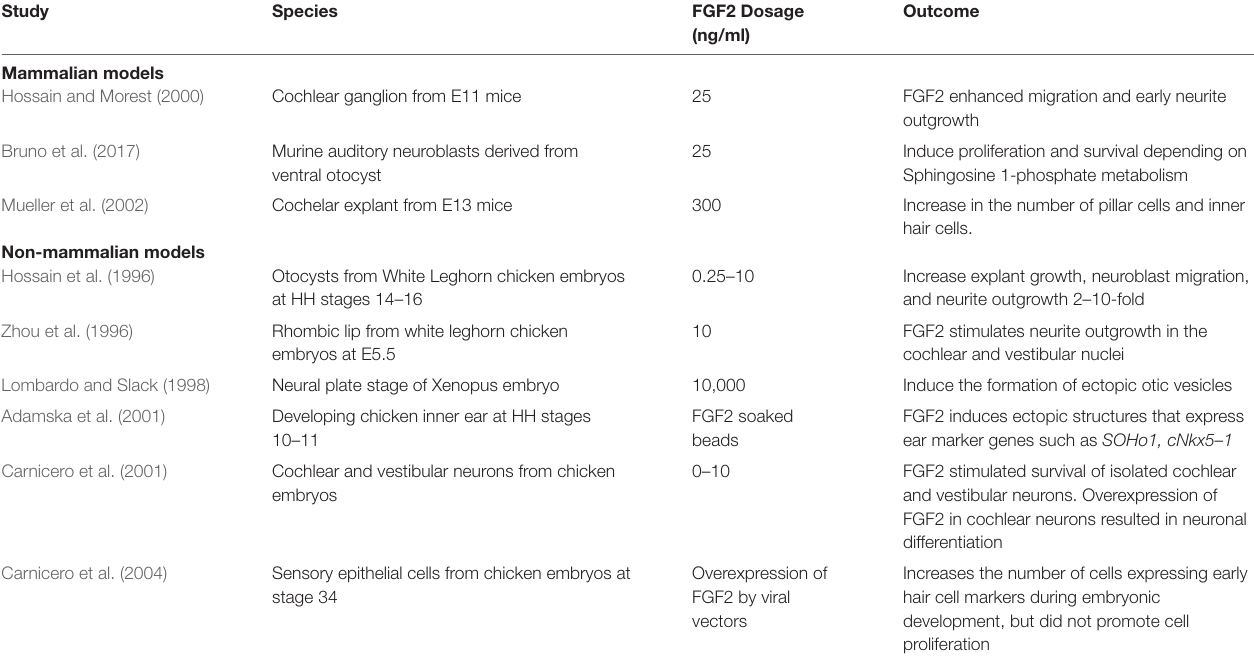
TABLE 1 | Studies of exogenous FGF2 in developmental stage